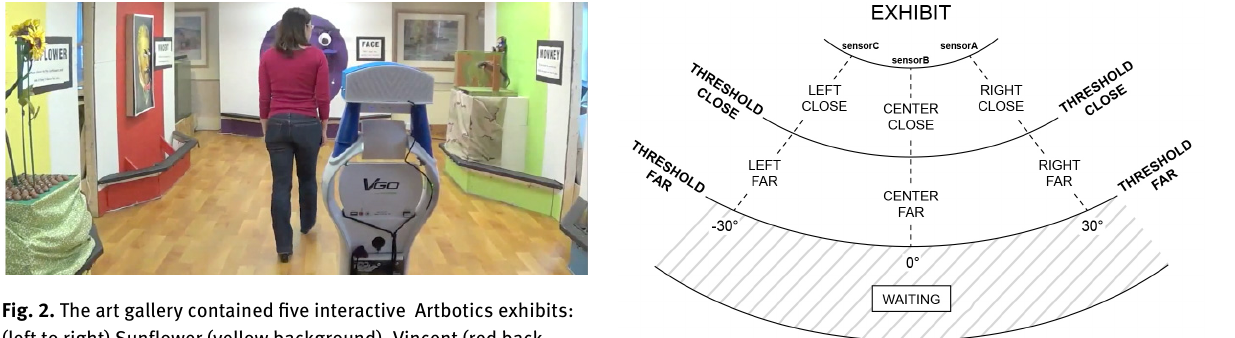
Fig. 3. Three sensors were placed in front of and below each exhibit. The center faced straight out while the left and right were aimed 30 ∘ in either direction with respect to the center. The area in front of each sensor is defined as an exhibit